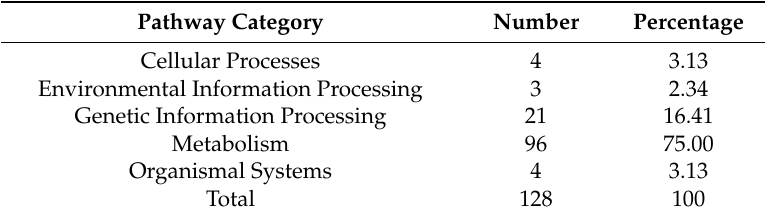
Table 4. Classification of annotated unigene pathways according to categorical processes based on KEGG Pathway Mapping.